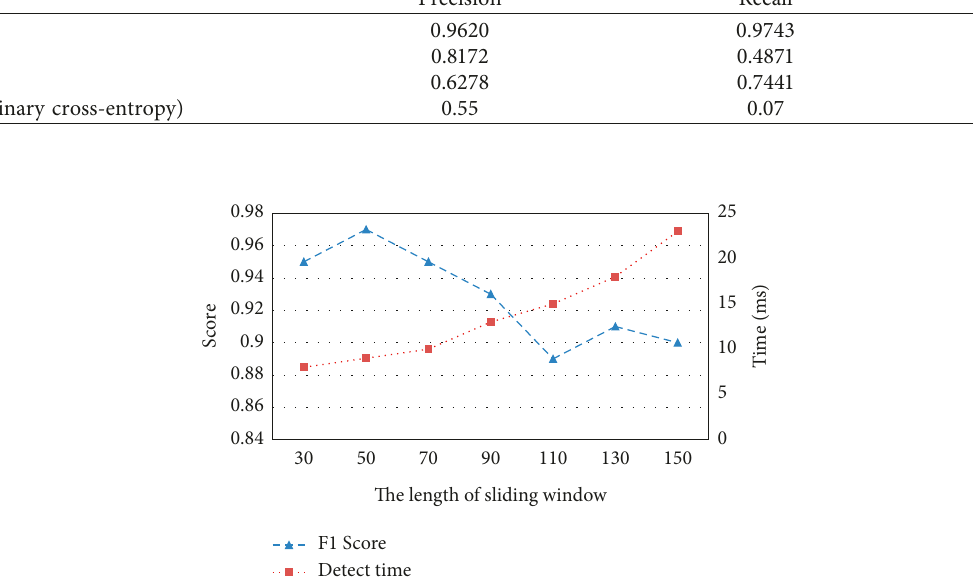
Figure 14: Performance of the model under different sliding